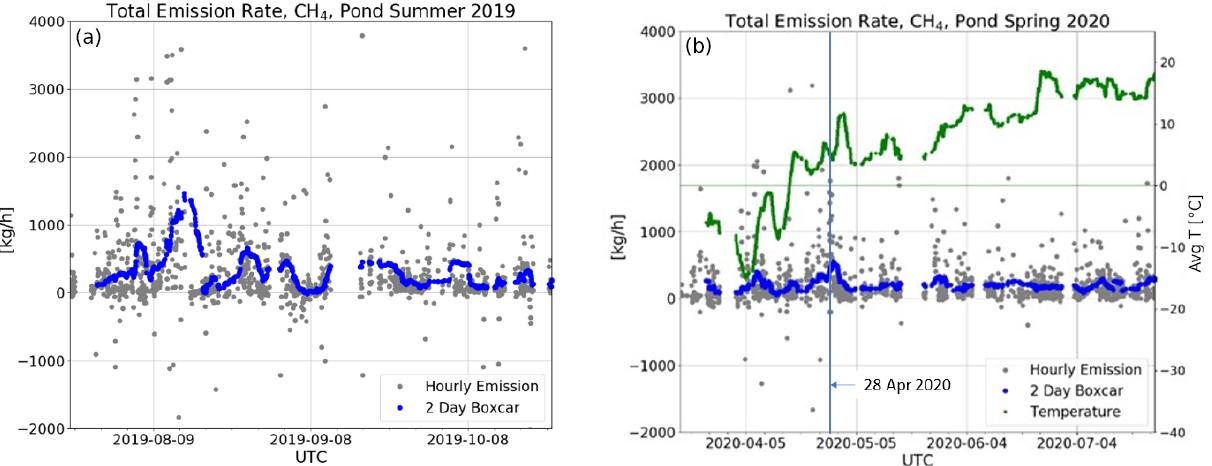
Figure 5. Tailings pond methane emissions for July–October 2019 (a) and March–July 2020 (b) , including hourly emission (gray) and two-day moving average (blue). Two-day moving average of local air temperature (green) corresponds to the right most y axis.